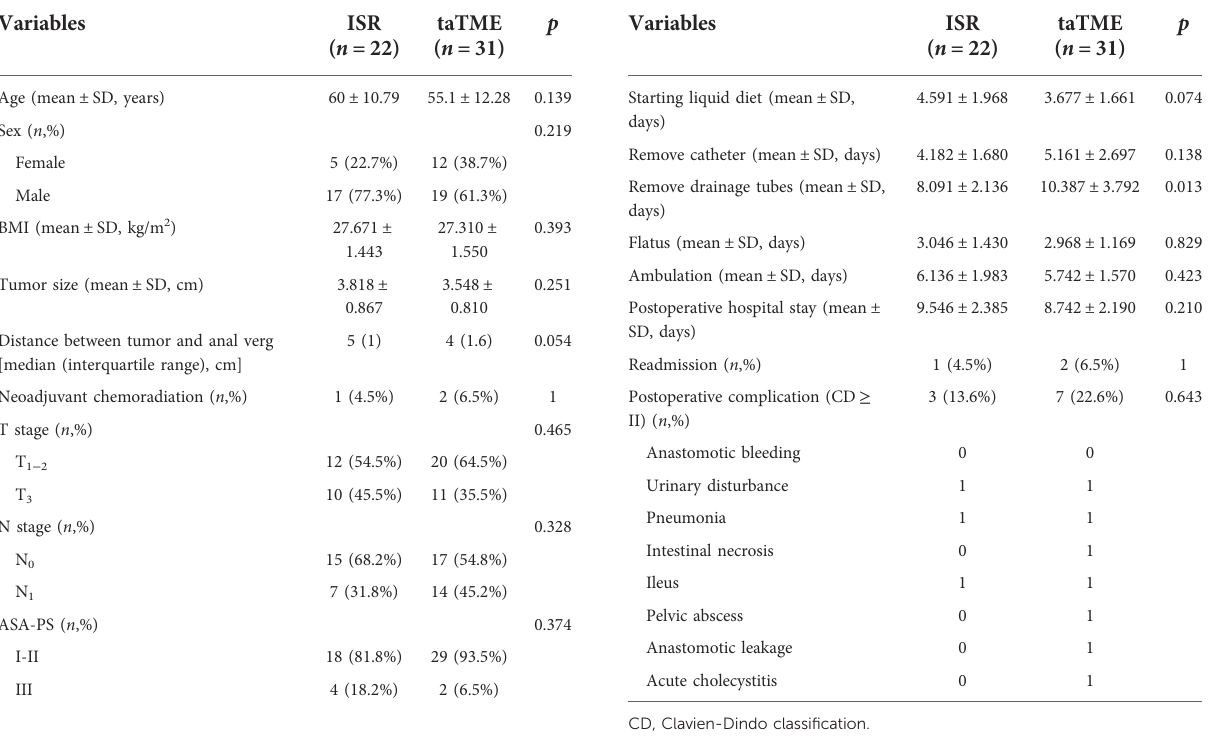
TABLE 1 Patient characteristics. TABLE 3 Postoperative short-term